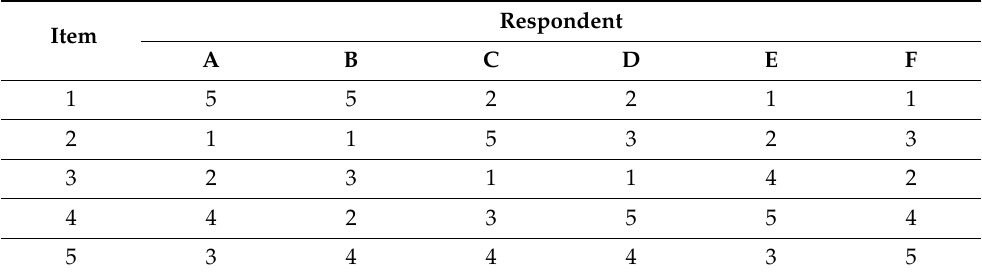
Table 4. Response of each item.